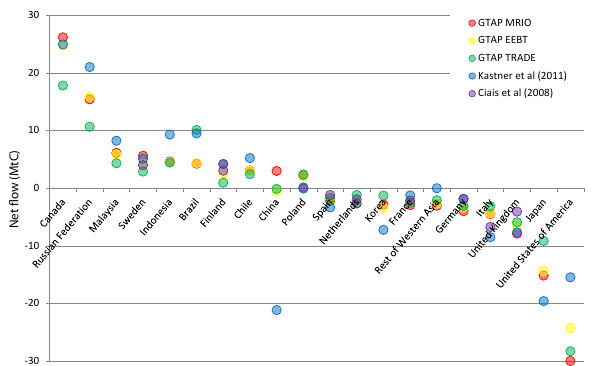
Fig. 11. A comparison of different methods of estimating the trade in harvested wood products (HWPs) for the 20 largest net (exports minus imports) flows (see text). The Ciais et al. (2008) results are for 1997, while all other studies are for